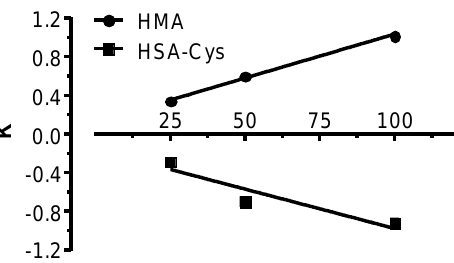
Figure 3. Regeneration effect of HSA-SH by NAC: Dose-dependent effect of NAC in regenerating HSA-SH (positive slope) and in breaking (negative slope) the cysteinylated form.